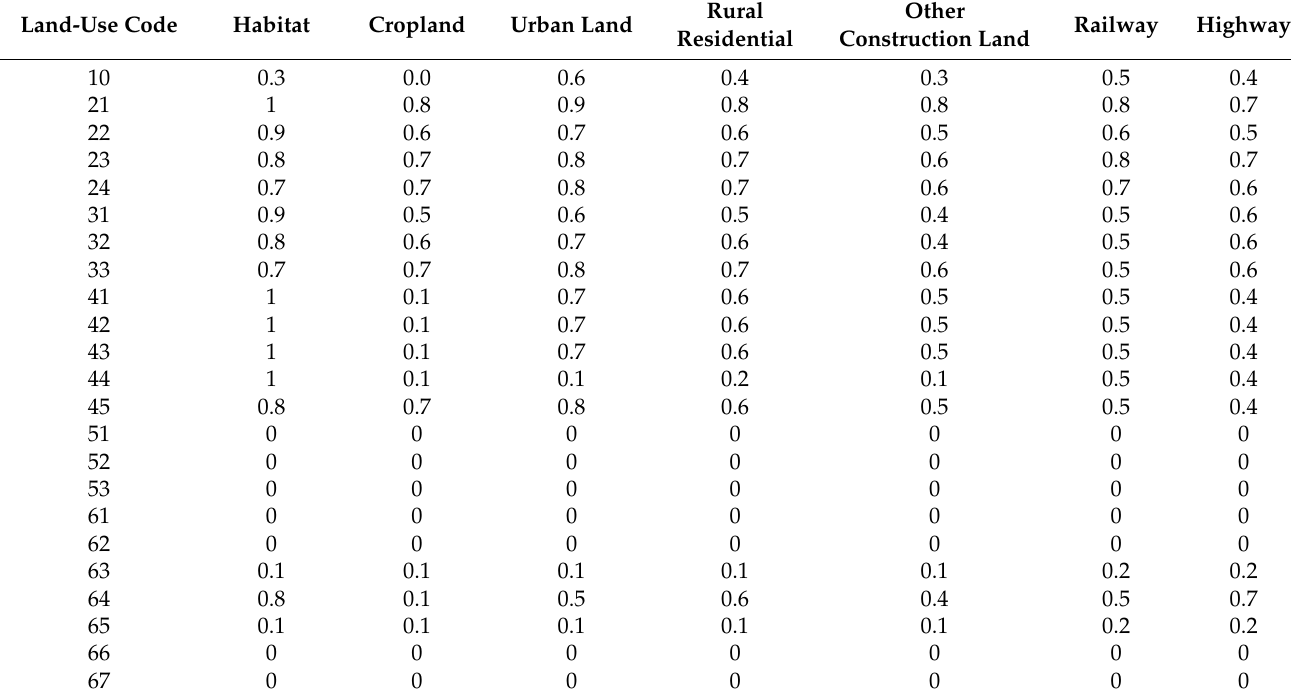
Table 2. Sensitivity of different habitat types to different threat